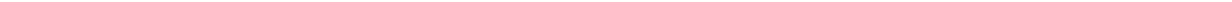
Figure 6 | Ccl2 improves delayed wound healing in postpartum conditions by recruiting FMCs. ( a ) Experimental design: Each mouse received 12 daily topical applications of dermoval cream after the delivery. An 8mm wound was created on the clobetasol-treated skin of the female mice postpartum (these mice had carried eGFP þ foetuses) and we injected PBS or Ccl2 into the lesion immediately and 2 days after skin excision. ( b ) Time course analysis of the healing of the excisional skin lesion; a representative image is shown. Scale bars: 1mm. ( c ) Planimetry of the wound area relative to the initial wound area at each time point ( n ¼ 5). ( d ) Anti-K14 (red) labelling of neoepidermal tongues and gaps in the wound on day 7. Scale bars: 1mm. ( e ) Measurement of neoepidermal tongues and gaps ( n ¼ 4). ( f ) Anti-Ki67 (green) labelling of the wound. Scale bars: 50 m m. ( g ) Quantification of Ki67 þ cells in epidermal wound edges (EpiD) and the dermal granulation tissues (D) ( n ¼ 3). ( h ) Dual labelling for CD31 (red) and LYVE1 (green). Scale bars: 50 m m. ( i ) Quantification of relative vessel area per 20 (cid:3) field by fluorescence densitometry ( n ¼ 3). ( j ) Quantification of the number of vessel types per 20 (cid:3) field ( n ¼ 3). ( k ) Quantitative RT–PCR analysis of VEGF-A , VEGFR1 and VEGFR2 mRNA levels normalized against mRNA levels for Gapdh ( n ¼ 3). ( l ) FACS analysis demonstrated the presence of a significantly larger number of eGFP þ cells in the wounds of postpartum mice treated with Ccl2 than in those treated with PBS ( n ¼ 3). ( m ) Quantification of eGFP þ cells in the wounds of postpartum mice receiving injections of PBS or Ccl2 ( n ¼ 3). Student’s t -test, * P o 0.05; mean ±